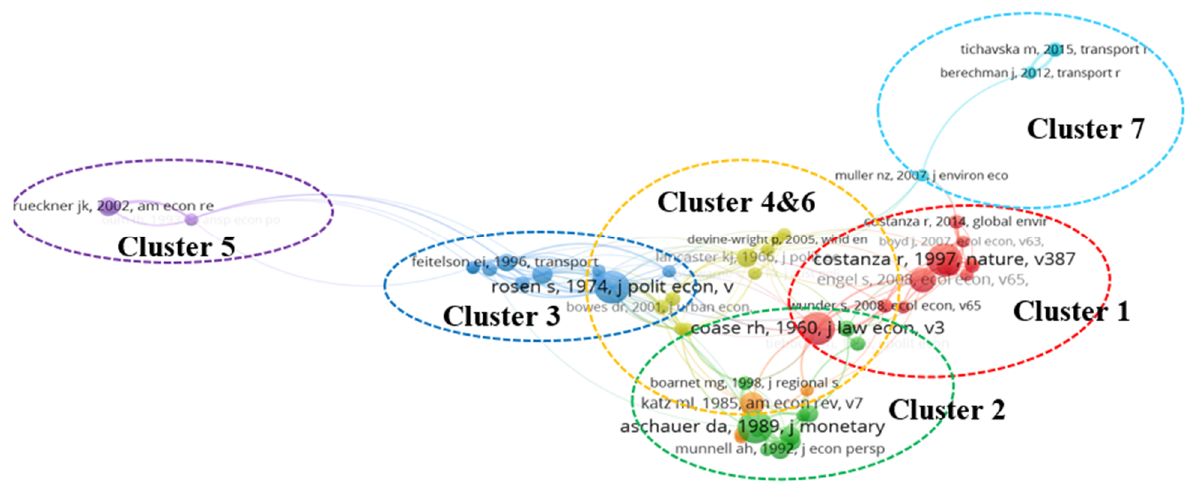
Figure 7. Scientific knowledgebase of infrastructure externalities research.